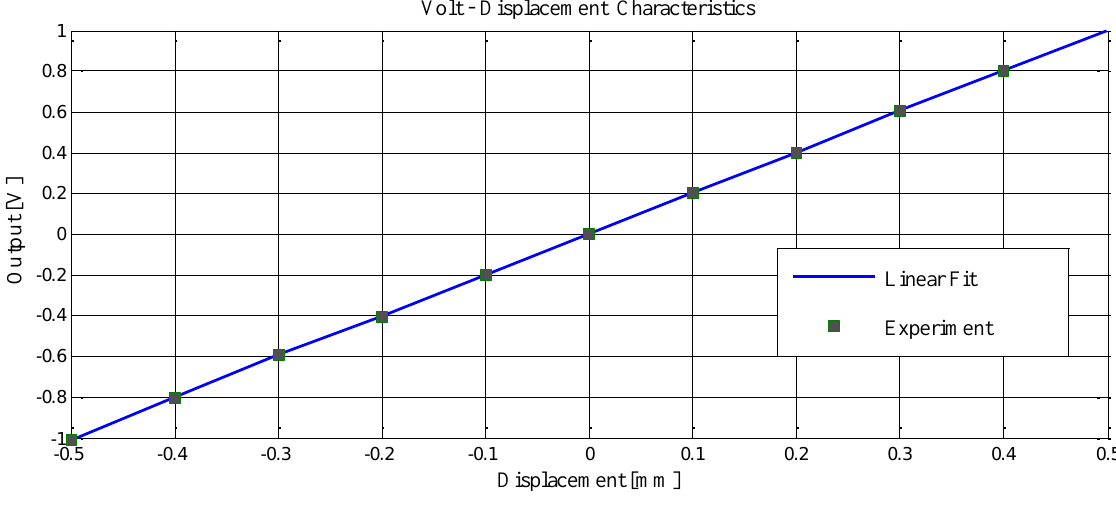
Figure 20. Volt-Displacement (mm) characteristic.